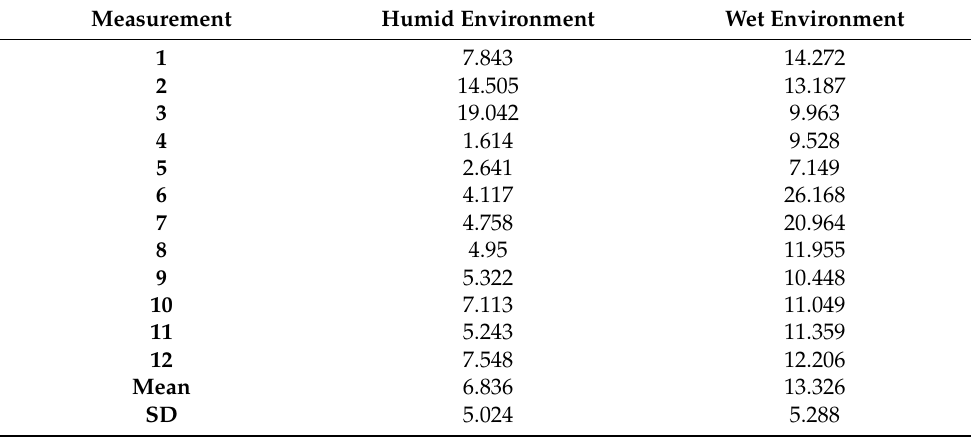
Table 1. Gap measurements at 1 mm between dentinal wall and bioceramic sealer ( µ m).